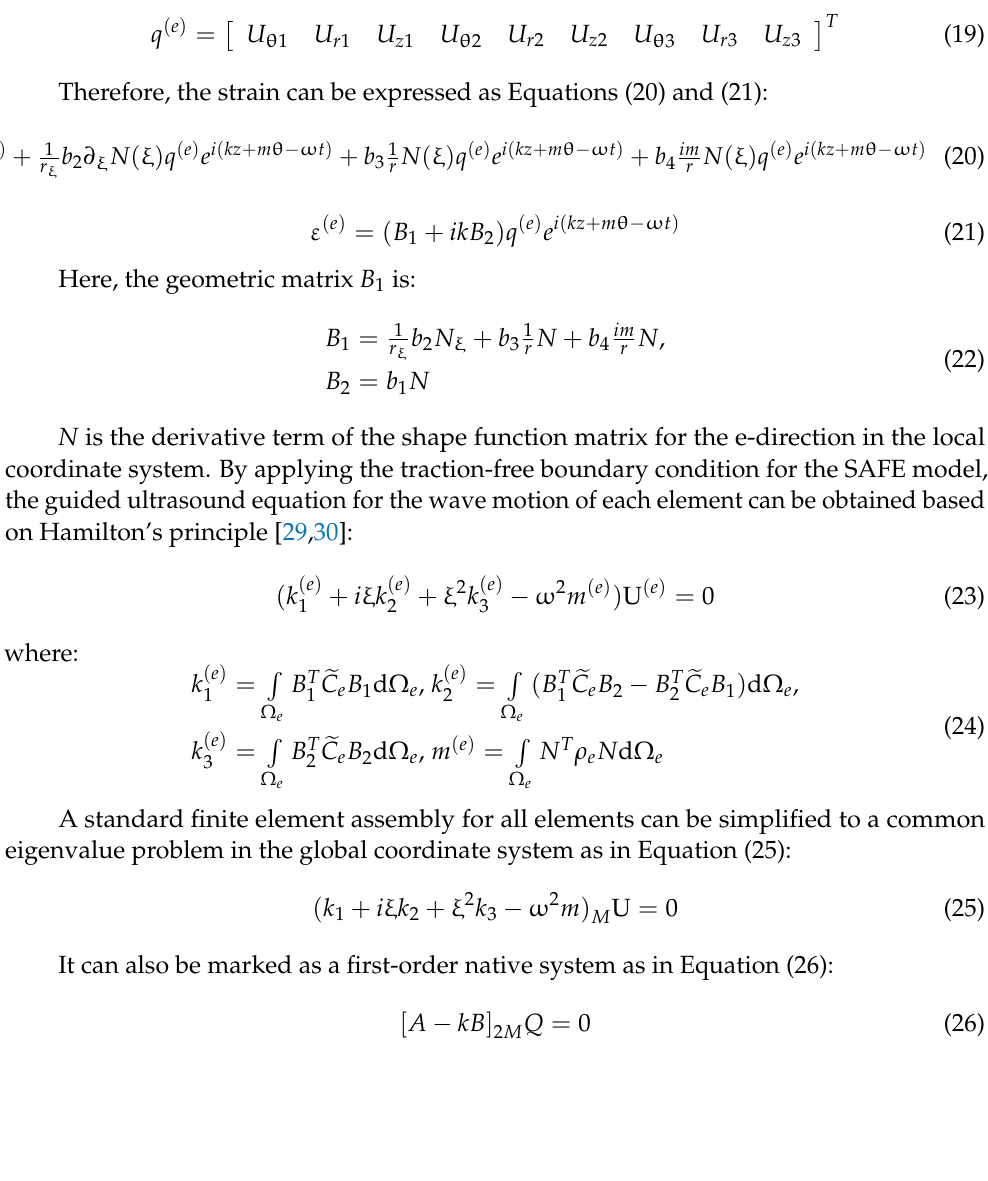
Figure 3. Discretization of a pipe with 1D three-node elements. The displacement field of each discrete element is described as a shape function ma- trix and a node displacement vector after finite element discretization.